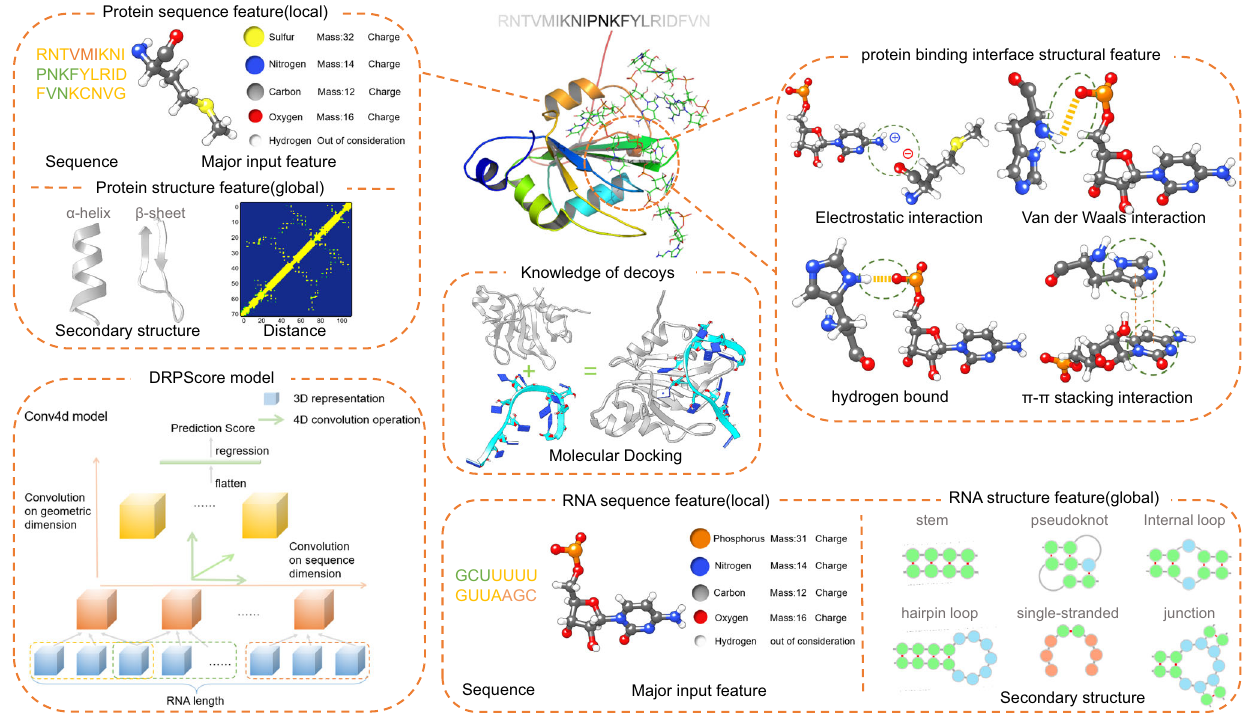
Fig. 6 | The input features ofthe DRPScore model. DRPScoreconsidersboth local and global features from the RNA-proteincomplex.The local features aresequence, mass, and charge for each atom. The global features are secondary structures, nucleotide-residue distances, and interface